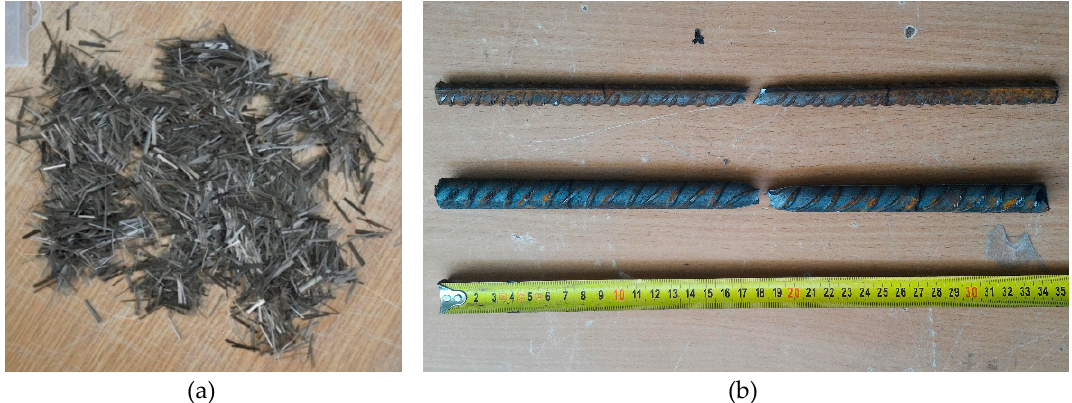
Figure 1. ( a ) Fibres used in experimental work; ( b ) reinforcing bars after tensile test.